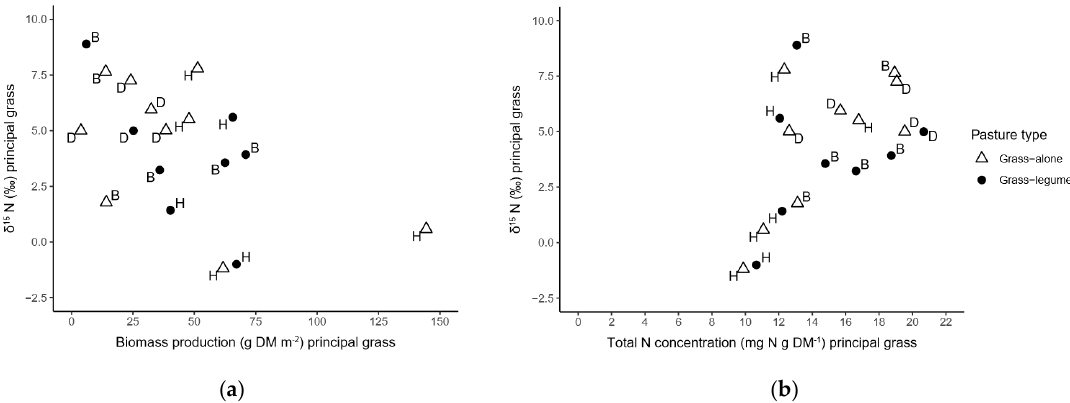
Figure 3. ( a ) Relationship between biomass production and δ 15 N signature of principal grass shoot, r = − 0.5, p < 0.05. ( b ) Relationship between total N concentration and δ 15 N signature of principal grass, r = 0.5, p < 0.05. Open triangles represent grass-alone pastures, n = 10. Full circles represent grass-legume pastures, n = 8. H = Urochloa humidicola , D = U. decumbens , B = U. brizantha .